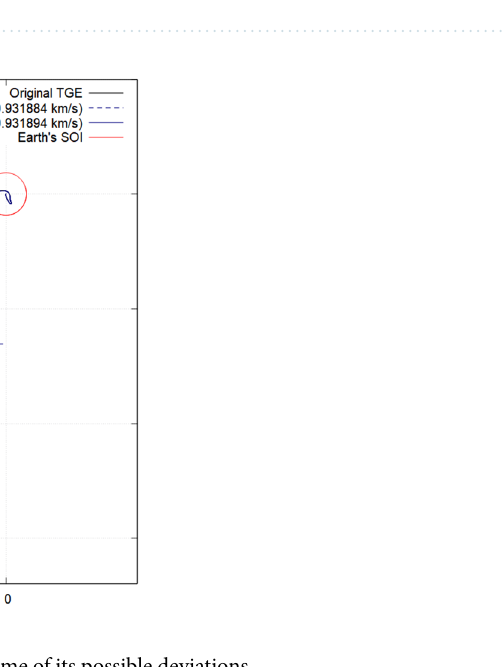
Figure 8. ( a ) Didymos interception for a tof of 306 days and sail loading of 30.6 g / m 2 . ( b ) Sail guidance properties as a function of the time.